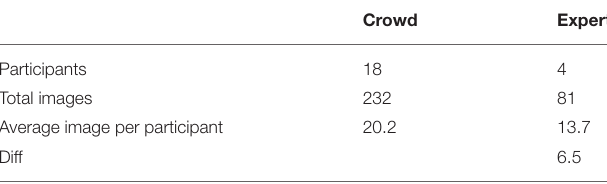
TABLE 3 | Average image count by group.